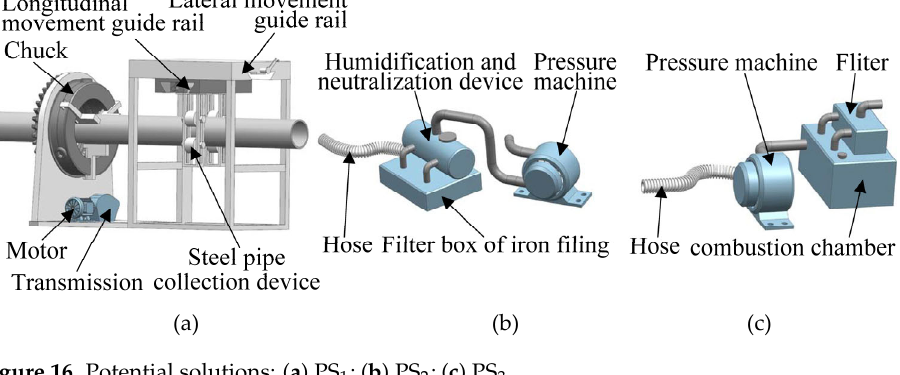
Figure 16. Potential solutions: ( a ) PS 1 ; ( b ) PS 2 ; ( c ) PS 3 .